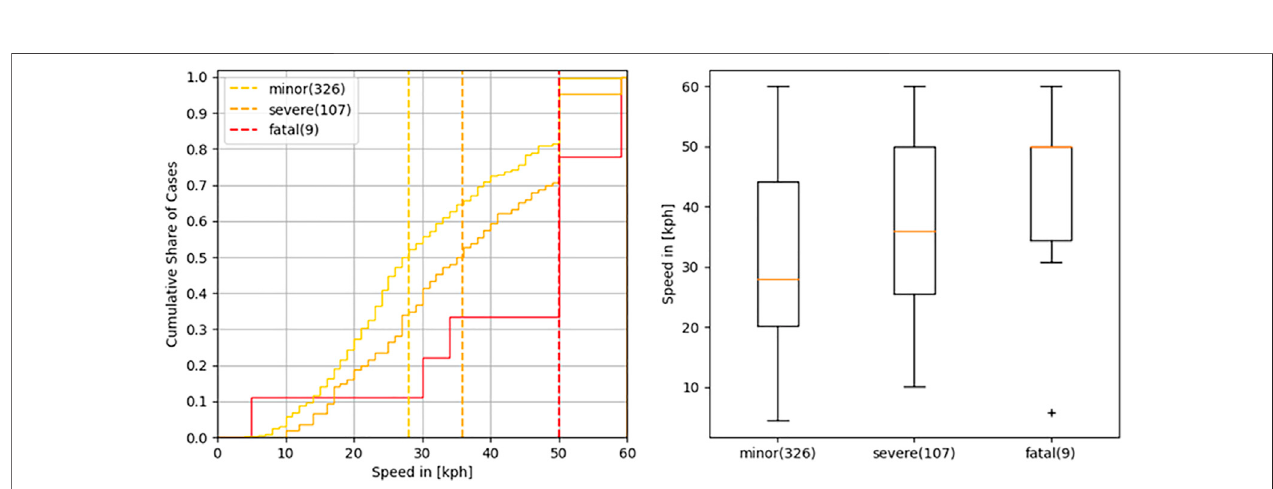
FIGURE5| EstimateddistributionoftramcollisionspeedsforpedestrianaccidentsinthecityofVienna(443casesintheperiod2014 – 2020),highlightedaccording to their severity.